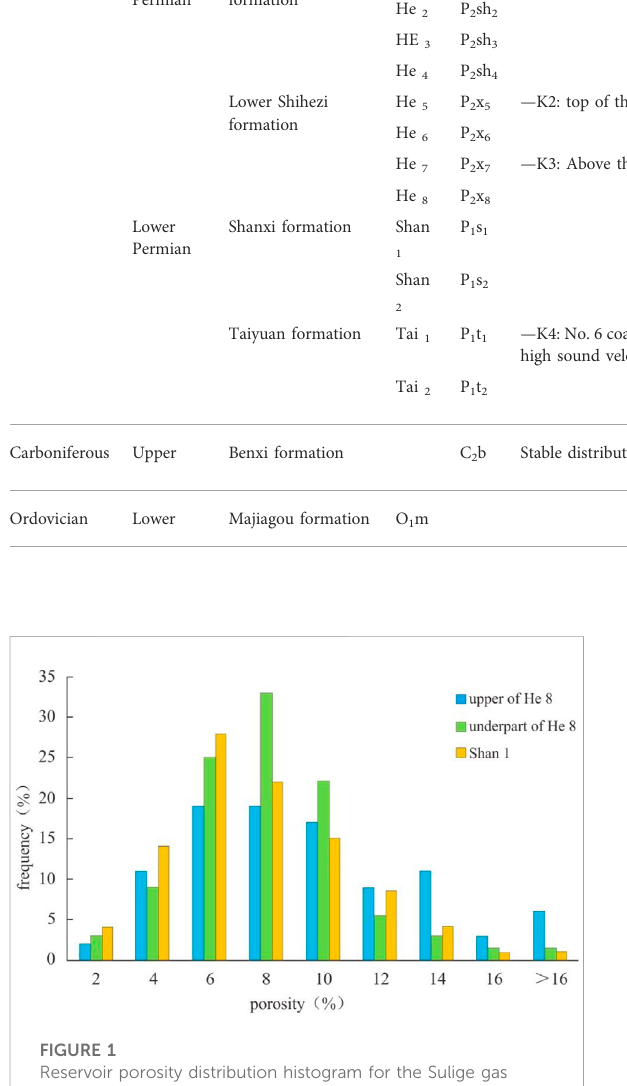
FIGURE 1 Reservoir porosity distribution histogram for the Sulige gas fi eld.